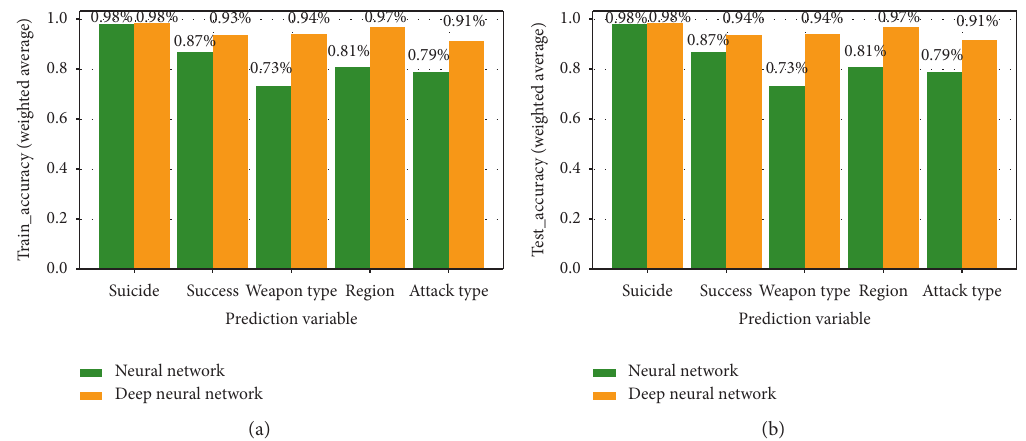
Figure 5: Train and test accuracy by neural network and deep neural network in making predictions of suicide, success, weapon type, region, and attack type. (a) Train accuracy by neural network and deep neural network. (b) Test accuracy by neural network and deep neural network.